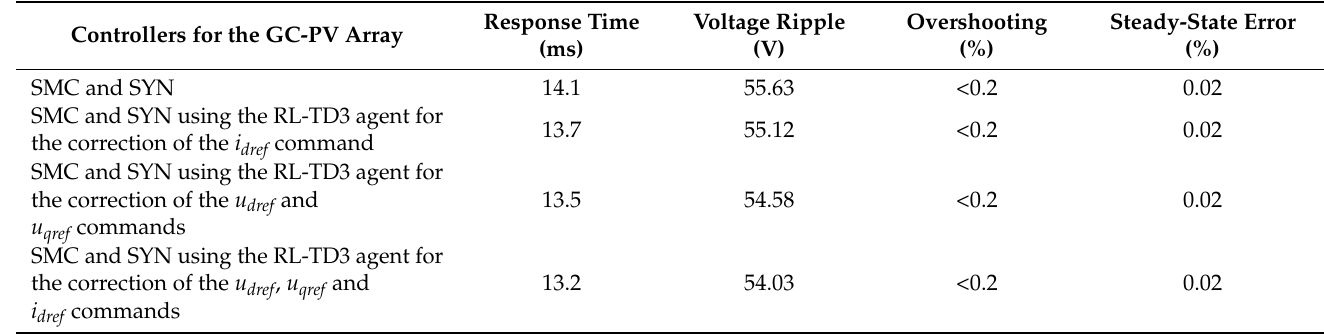
Figure 50. The comparison of voltage u dc for a step variation of the u dcref reference voltage from 500 V to 550 V using SMC- and SYN-type controllers and the RL-TD3 agent for the outer and inner loop corrections (signal evolution of the type 2 PV array). Table 2. The performances of the GC-PV control systems based on SMC and SYN controllers using the RL-TD3 agent.